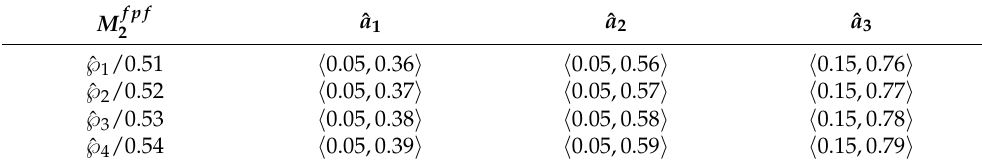
with entries in terms of CFNs. 2